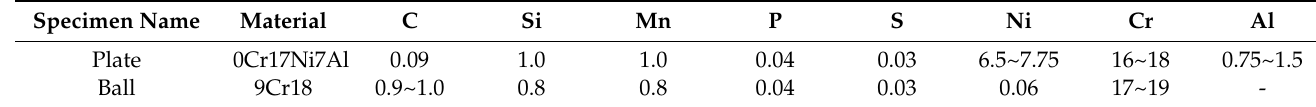
Table 7. Chemical composition and mass fraction of friction pair.